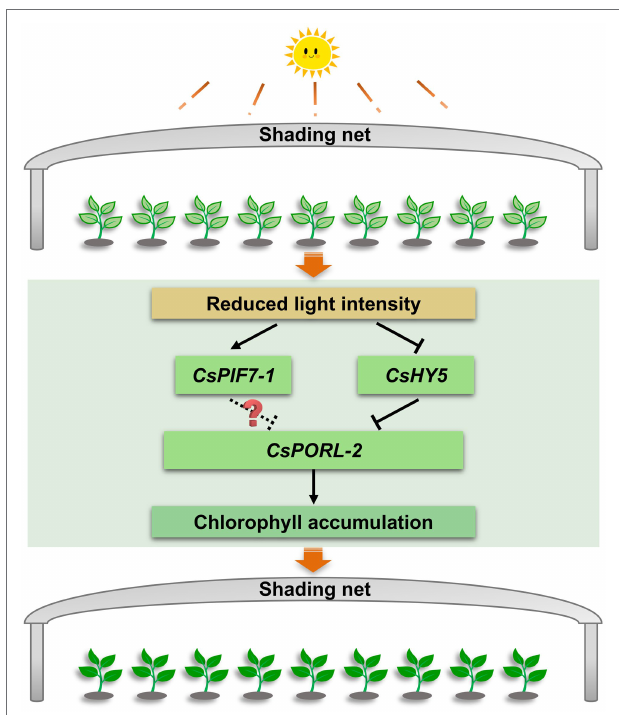
FIGURE 7 | The regulation mechanism model of chlorophyll accumulation under shade treatment of tea plants. After shading, the decrease of light intensity affects the transcription level of CsHY5 and CsPIF7-1 , which in turn regulates the expression of the chlorophyll synthesis gene CsPORL-2 , and causes the accumulation of chlorophyll in tea leaves. Arrows and bars indicate positive regulation and negative regulation, respectively. The solid line indicates the regulatory mechanism in this study, while dashed line and question mark indicate unknown